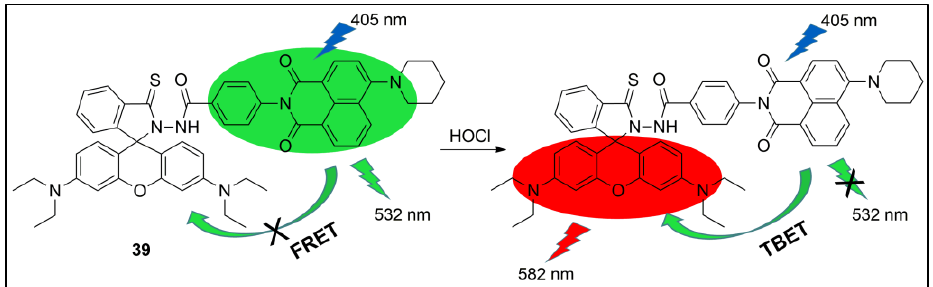
Figure 40. The proposed mechanism of 39 for sensing HOCl [124].